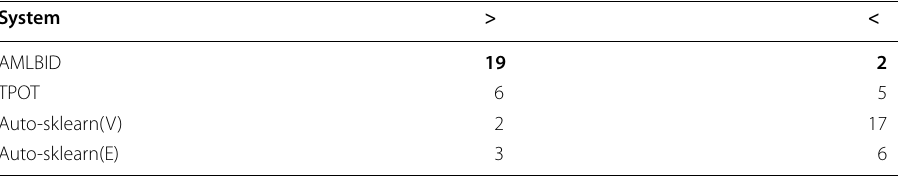
We count how many times the system performs better (>) or worse (<) The best performances among all AutoML frameworks are highlighted in